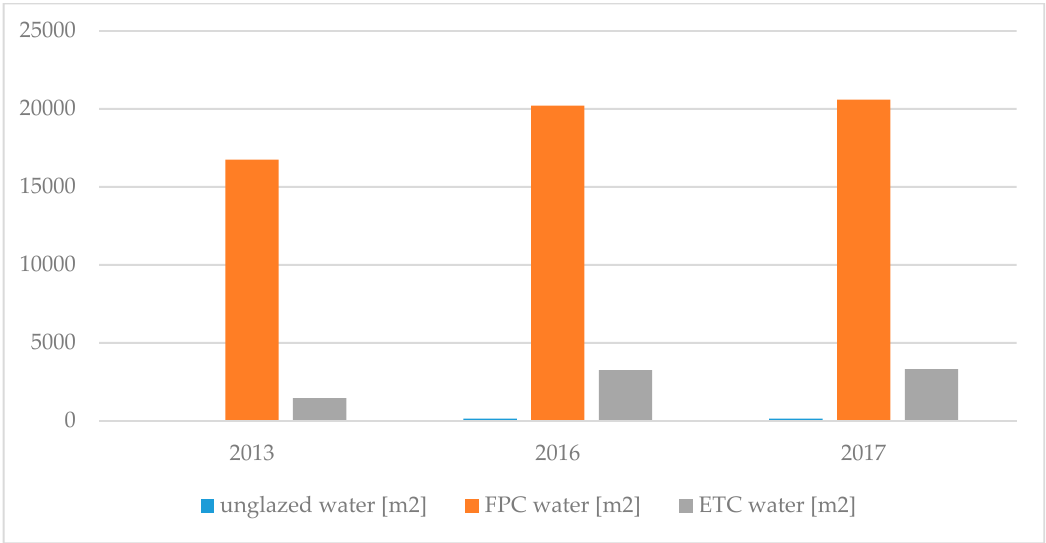
Figure 9. Gross area of solar collectors (for all applications) in Russia.